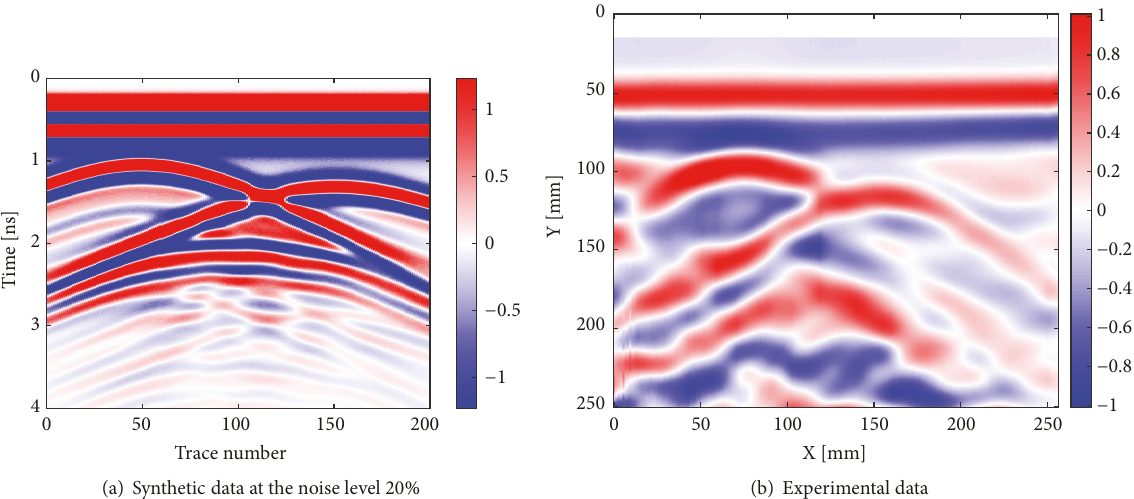
Figure 10: Comparison of the B-scan images with the synthetic data at noise level 20% (a) and experimental data